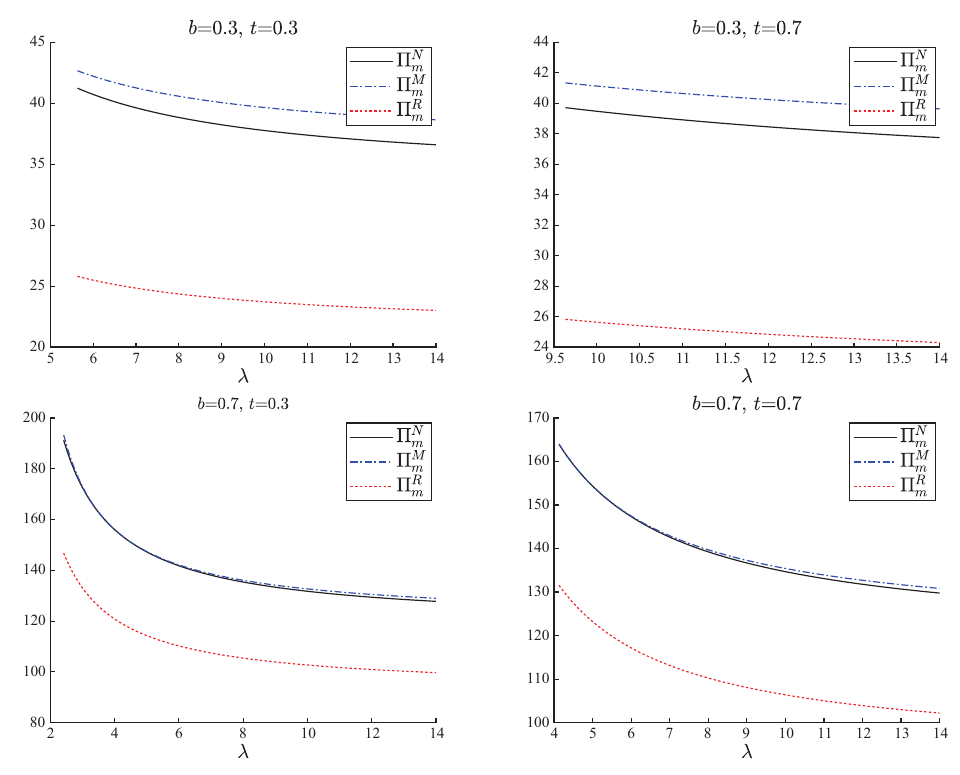
Figure 5. The manufacturer’s optimal